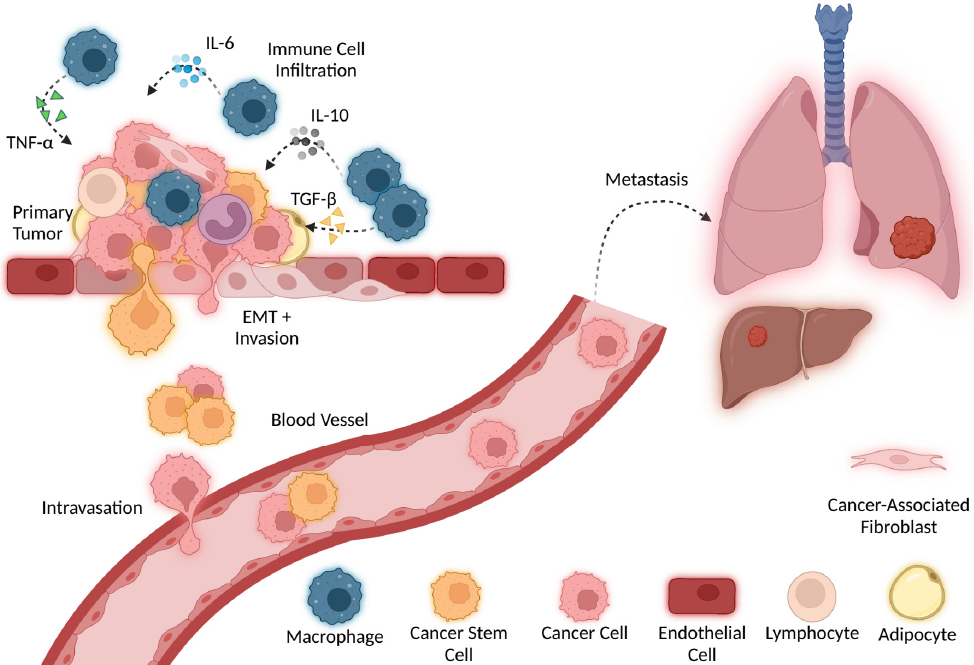
Figure 4. CSCs and cytokines secreted by immune cells infiltrating the tumor promote EMT and invasive activity. Eventually, cancer cells may intravasate into local blood vessels to metastasize and colonize other tissues.